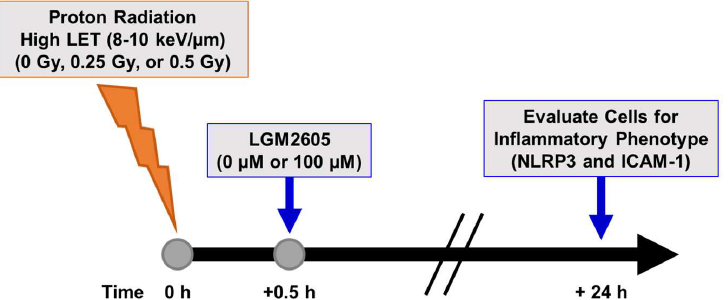
Scheme 4. Experimental plan of high LET proton radiation exposure of in vitro lung vascular networks (flow-adapted endothelial cells) and LGM2605 treatment. FAECs were exposed to 0 Gy, 0.25 Gy, or 0.5 Gy high LET (8–10 keV/ µ m) proton radiation and treated with 0 µ M or 100 µ M LGM2605 30 min following radiation exposure. Cells were harvested 24 h post radiation exposure and evaluated for inflammation and inflammasome